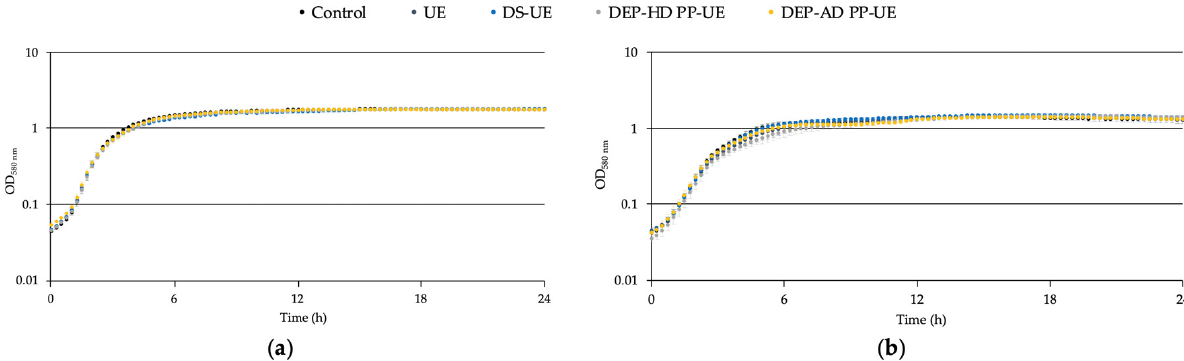
Figure 1. Effects of poly- and oligosaccharide Ulva sp. fractions at 1000 μg /mL on the growth kinetic of ( a ) S. aureus MFP03 ( n = 3) and ( b ) S. epidermidis MFP04 ( n = 3). Representation of the growth kinetic curve and error standard of each measurement are in log 10 scale.